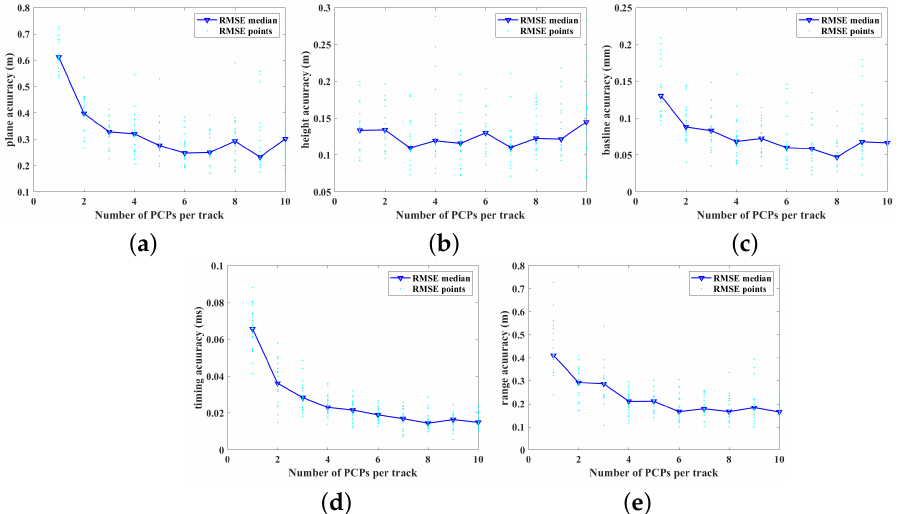
Figure 9. RMSEs of parameters after adjustment in the simulated experiment for the number of PCPs. ( a , b ) are the horizontal and vertical adjustment accuracies, respectively. ( c – e ) are the RMSEs of parallel baseline, slant range, and timing parameters, respectively. The data points are the results of all experiments, and the lines are median change curves of RMSEs of each group of